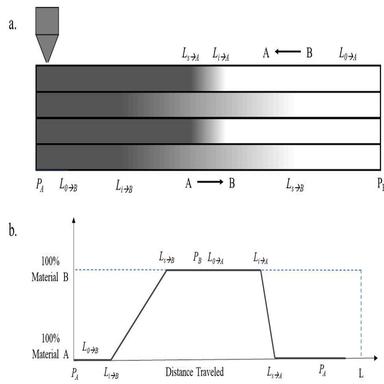
a. A schematic of a four-layer bead with transitions limited to one direction per layer where gray is Material A and white Material B. b. The change in material composition as a function of distance traveled for the first two layers.